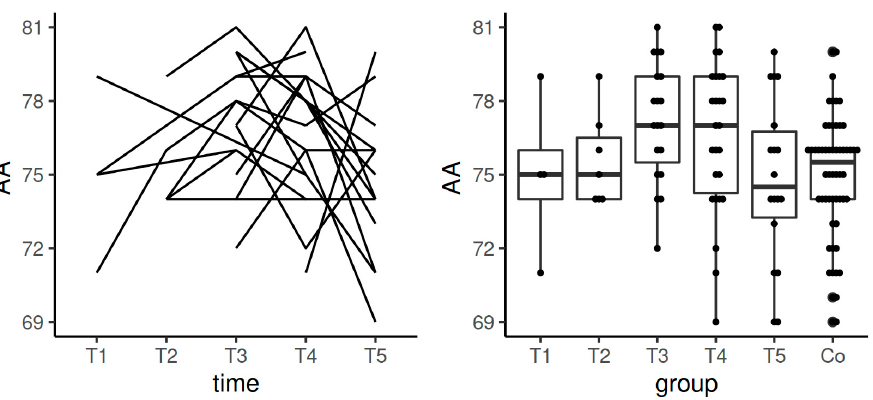
Figure 9. Spaghetti plot of the data from the longitudinal study (left) and swarmplot with boxplot of the same data together with the data from the control group (right)—the results of AA in HEP- the same data together with the data from the control group ( right )—the results of AA in